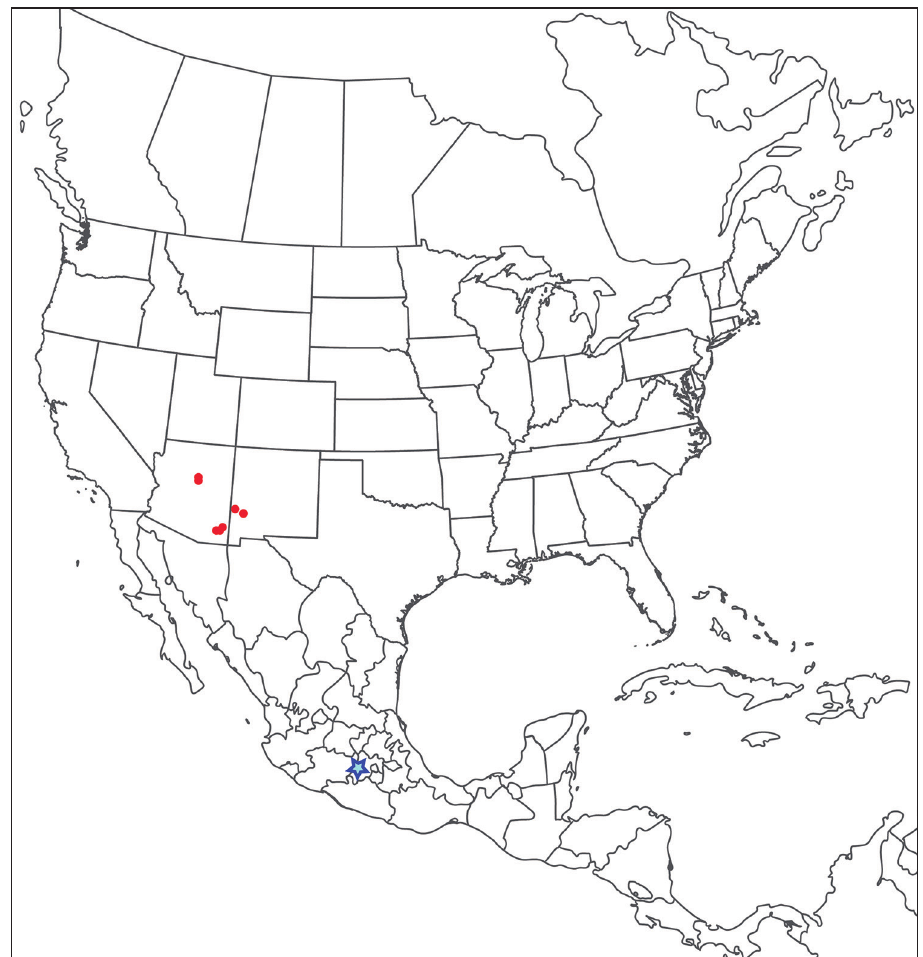
Figure 111. Torrenticola keesdavidsi distribution. Blue star represents type locality (Cramer 1992); and red circles represent new records and material